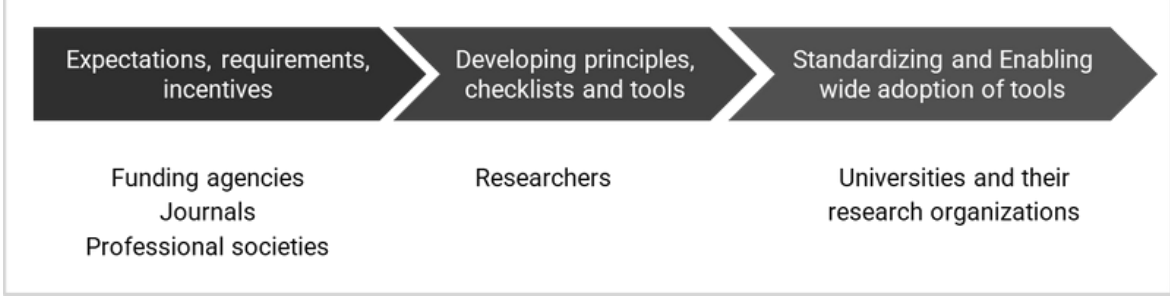
Figure 1. Universities and their research units can fill an important gap for research